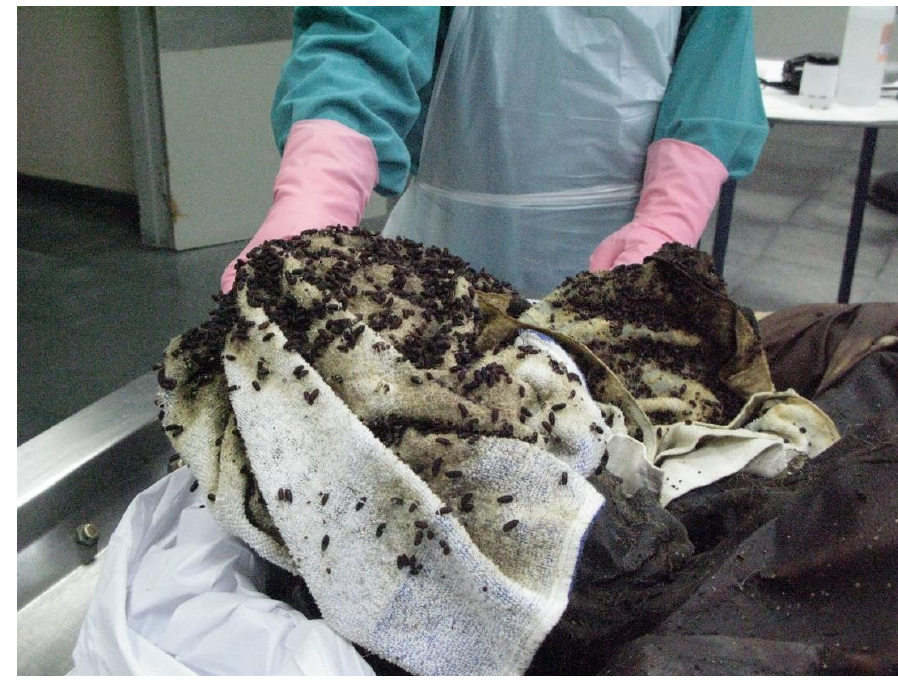
Figure 2. Autopsy procedure showing puparia from Chrysomya albiceps